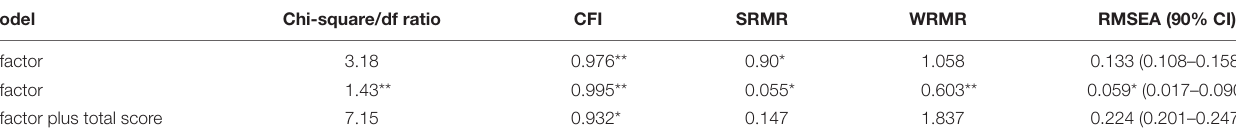
TABLE 2 | Results of the confirmatory factory analysis with three different models, across n = 124 participants. Model Chi-square/df ratio